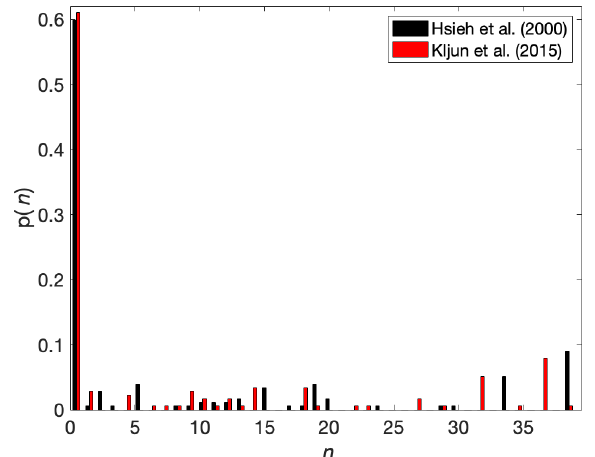
Figure 10. The probability ( p ( n )) of the number of bison ( n ) in the 90% flux footprint for the Hsieh et al. (2000) and Kljun et al. (2015) footprint models for periods when flux measurements were made and camera imagery was